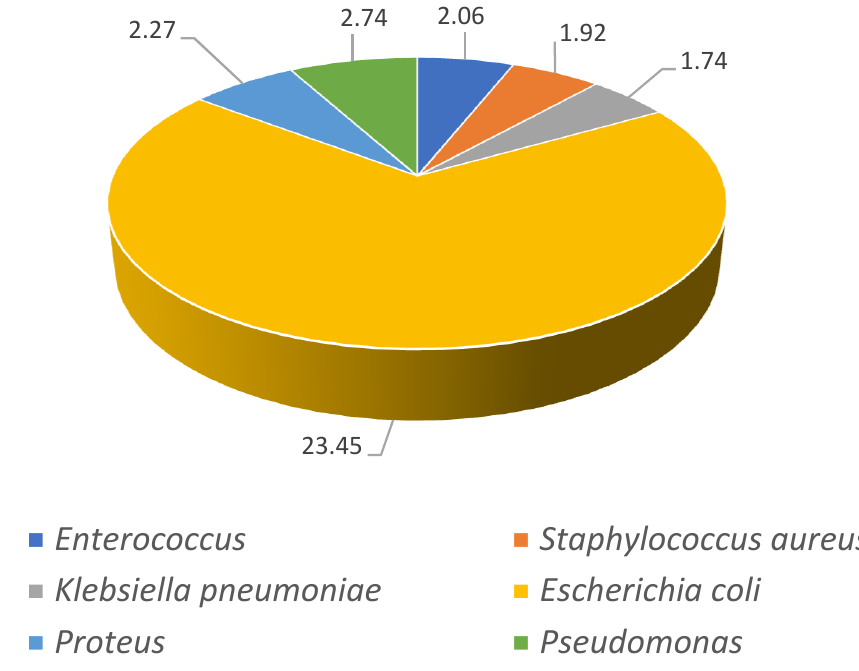
Figure 2. Prevalence of isolated pathogens for the first time period analyzed (2001–2003).